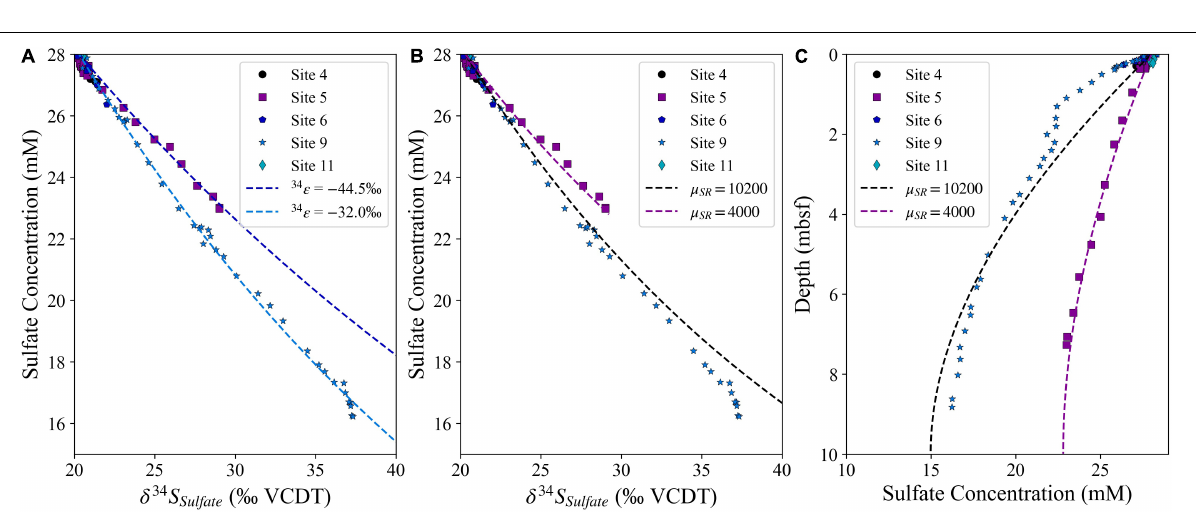
FIGURE 5 | Panel (A) displays the change in sulfur isotopic composition of sulfate for modeled Rayleigh fractionation lines for 34 ε of –44.5 and –32 compared to the measured data. Panels (B,C) display the change in sulfur isotopic composition of sulfate relative to the sulfate concentration and the sulfate concentrations relative to sediment depth, respectively using CrunchTope, with a constant 34 ε of –45